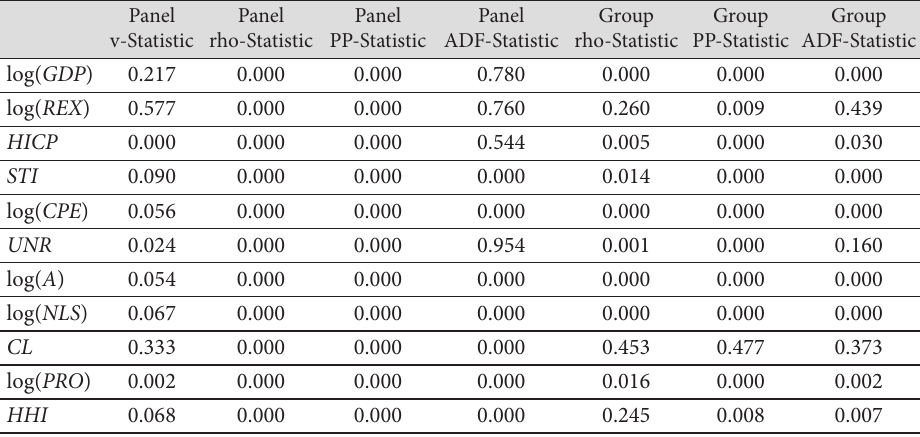
Table 10. Panel co-integration tests (net fee and commission income) Panel